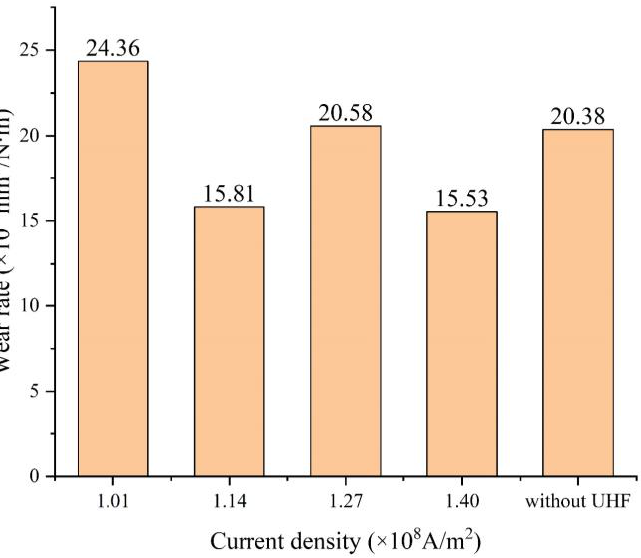
Figure 12. Wear rate of the laser − UHF induction hybrid deposited layers under different current densities.